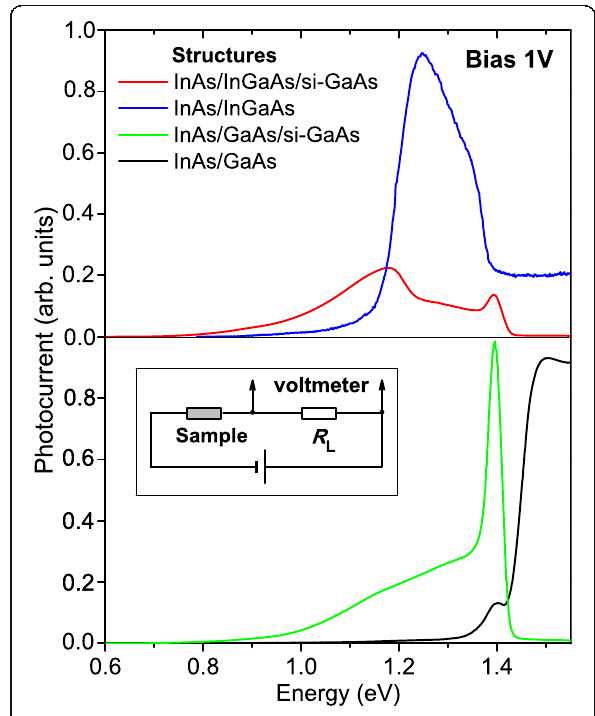
Fig. 4 (Color online) room temperature photocurrent spectra of the metamorphic InAs/In 0.15 Ga 0.85 As/ si -GaAs and conventional InAs/GaAs/ si -GaAs QD structures. Inset: electric scheme of connecting the sample for PC